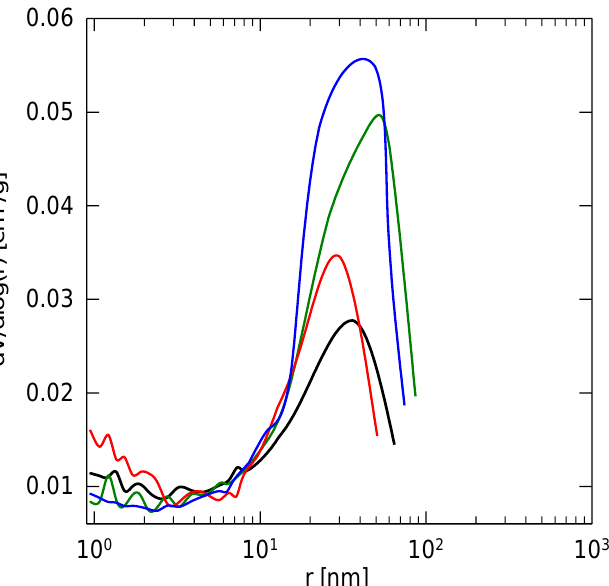
Figure 6. Pore-size distribution evaluated from the desorption branch of the nitrogen sorption isotherm at 77 K for the electrospun membrane ( — ) and catalysts ( — ): 0.08 Pt/PBI, ( — ): 0.54 Pt/PBI, ( ― ): 0.68 Pt/PBI.